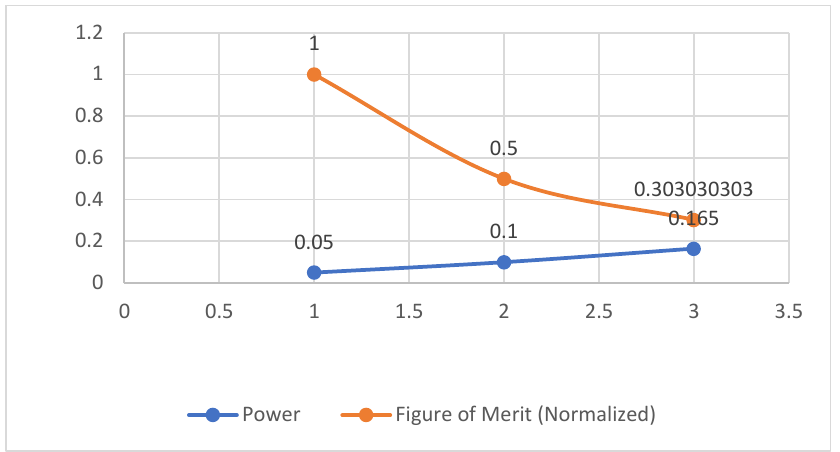
Figure 22. Figure of Merit (b/sW) change with power (W) at a fixed data rate.